Question: In a single sentence, describe what this figure presents.
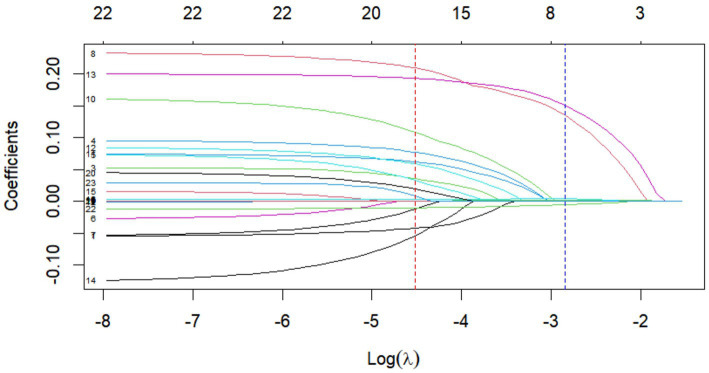
Answer: LASSO regression coefficient path plot.